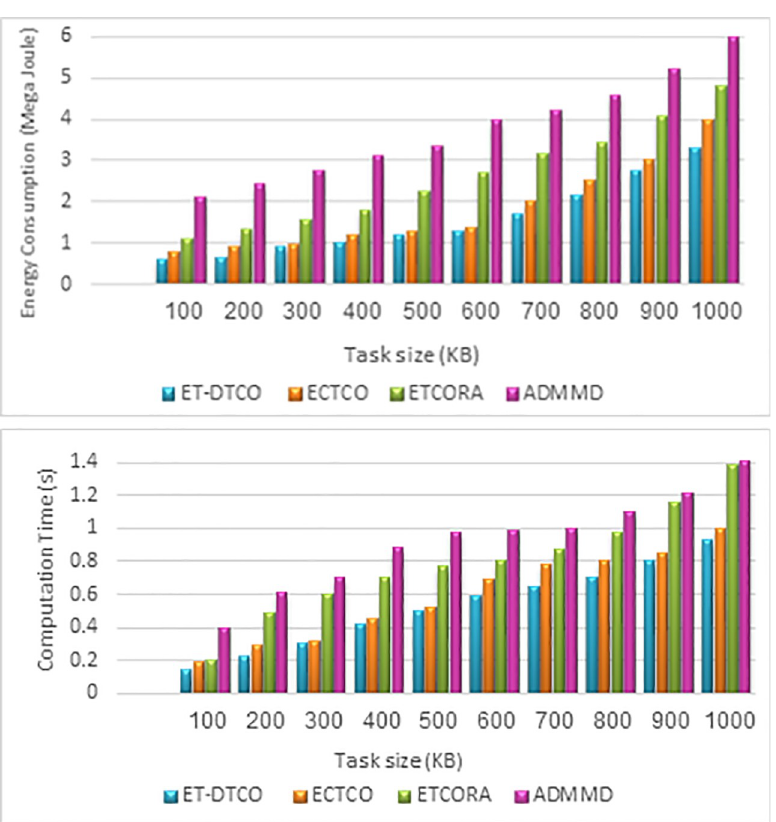
Fig 8. Impact of different task sizes on (a) energy consumption and (b) computation time for three